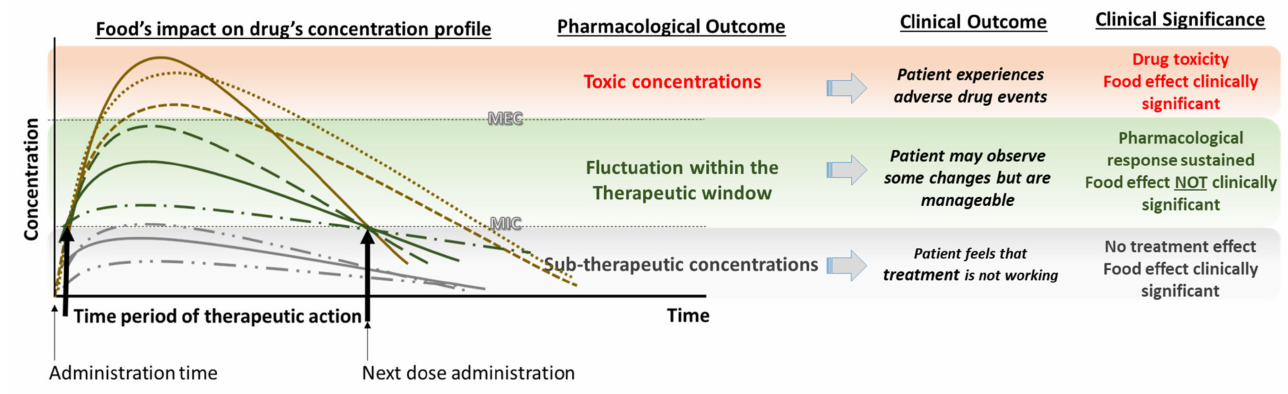
Figure 2. Graphical representation of food effect on the PK profile of a drug that leads in clinically significant DFIs (MEC maximum effective concentration, MIC: minimum effective